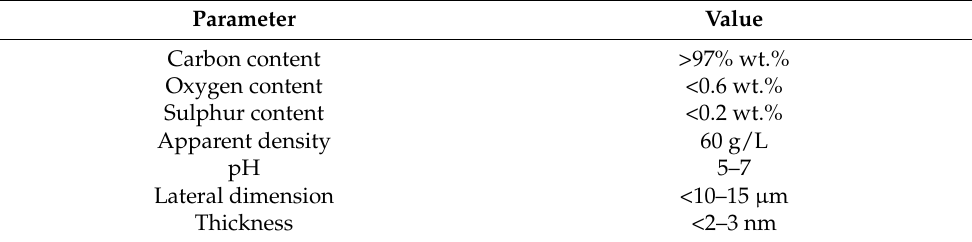
Table 2. Main characteristics of graphene nanoplatelets